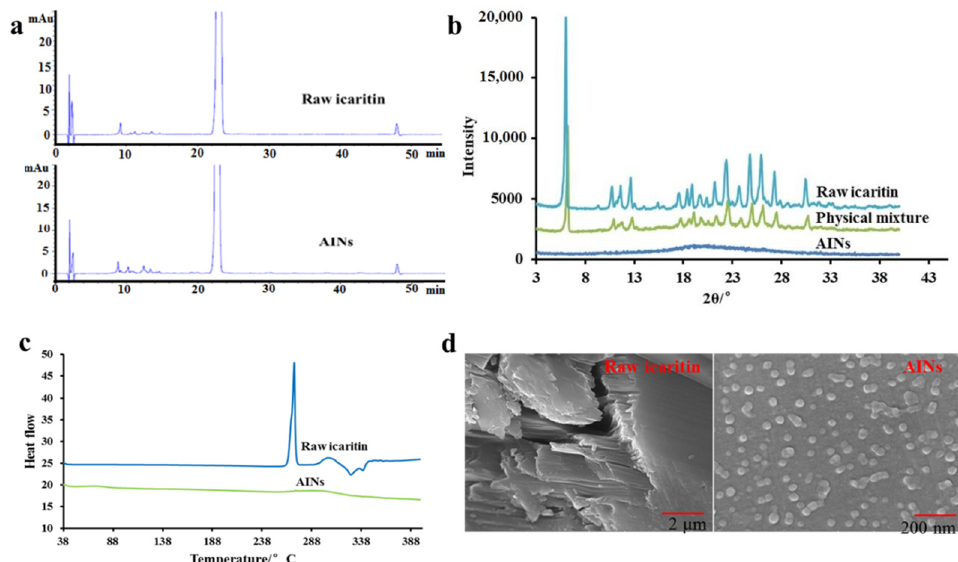
Figure 8. Impurity profiles of raw icaritin and AINs ( a ); XRPD of raw icaritin, physical mixture and AINs ( b ); DSC of raw icaritin and AINs ( c ); SEM of raw icaritin and AINs ( d ). AINs: amorphous icaritin nanoparticle; XRPD: X-ray powder diffraction; DSC: differential scanning calorimetry; SEM: scanning electron microscope.